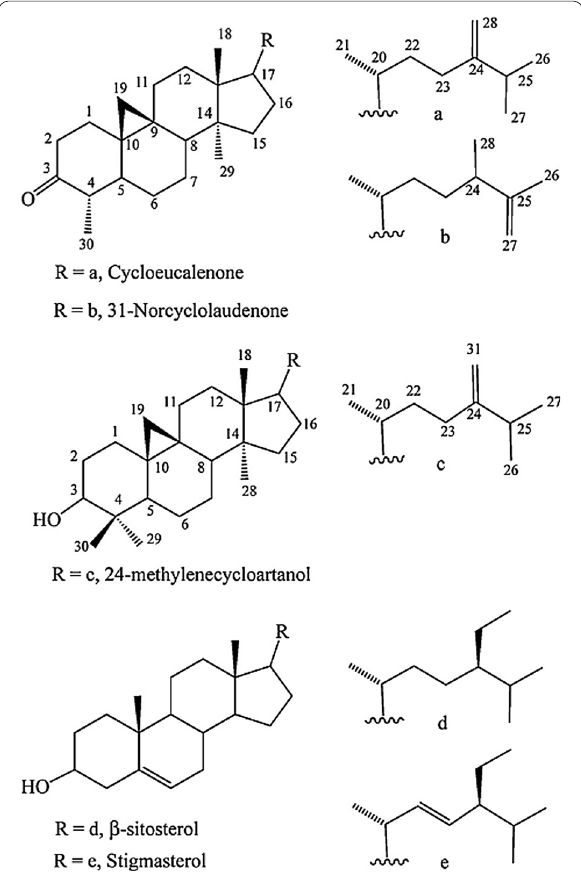
Fig. 1 Structure of putative phytosterols and triterpenes responsible for activity in M. paradisiaca (Silva et al.